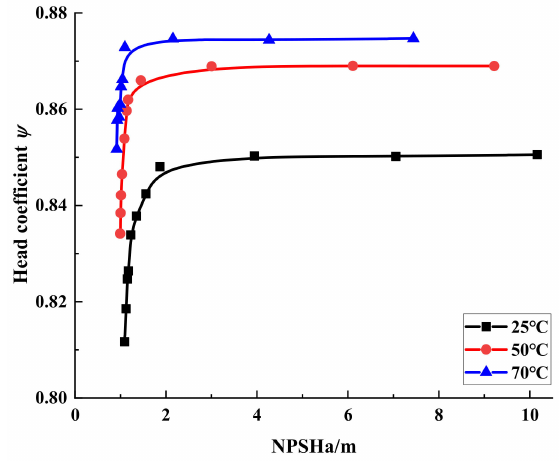
Figure 9. Cavitation performance curves with different temperatures.